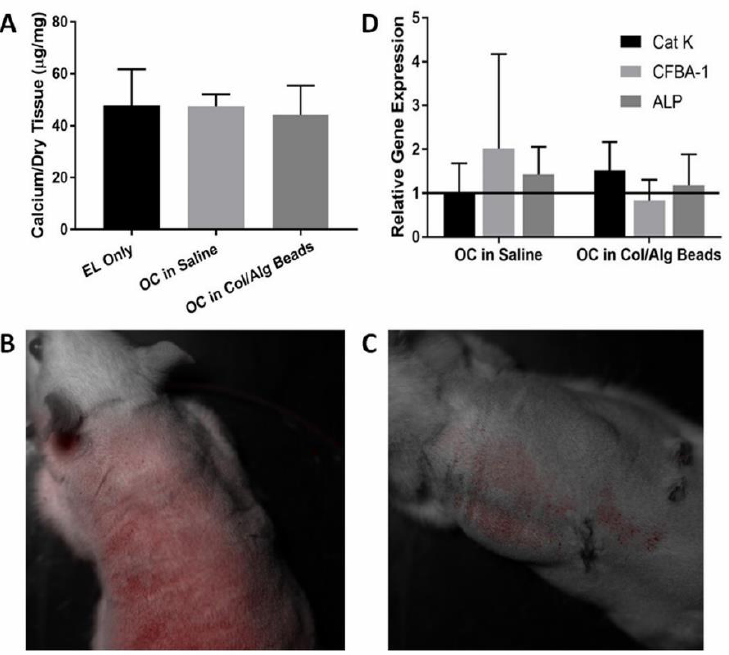
Figure 3. ( A ) The graph shows the calcium per dry tissue ( µ g/mg) for elastin, OCs, and bead delivery. Delivery of OCs by beads was ineffective in reversing calcification ( n = 4). ( B , C ) Fluorescently labeled OCs seven days after implantation remained localized during and after implantation. In B., the OC saline injection showed cells fluorescing throughout the body of the rat. However, in C., the bead delivery showed cells only fluorescing localized around the injection site. ( D ) The image depicts the relative gene expression of OCs either in saline or encapsulated in beads. Bead delivery showed lower CFBA-1 expression, but no significant difference was observed ( n = 4). Data were analyzed with ANOVA and Student’s t -test, with p < 0.05. No statistical difference observed ( p = 0.96).